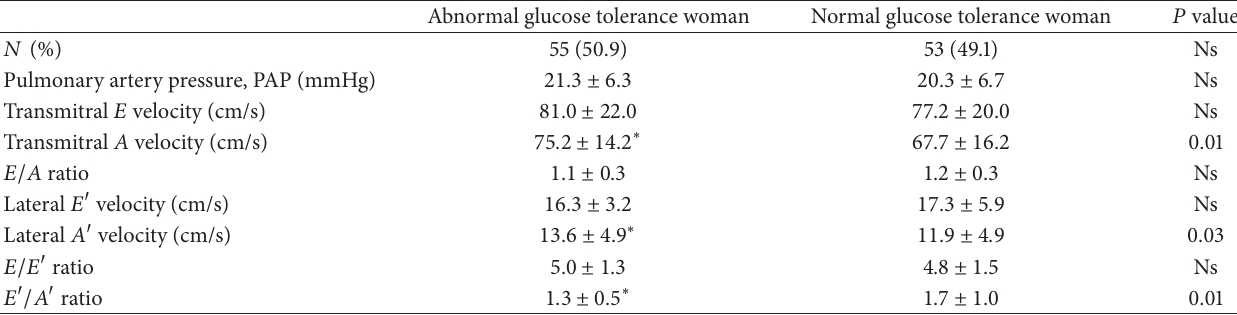
Table 3: Doppler and tissue Doppler parameters.